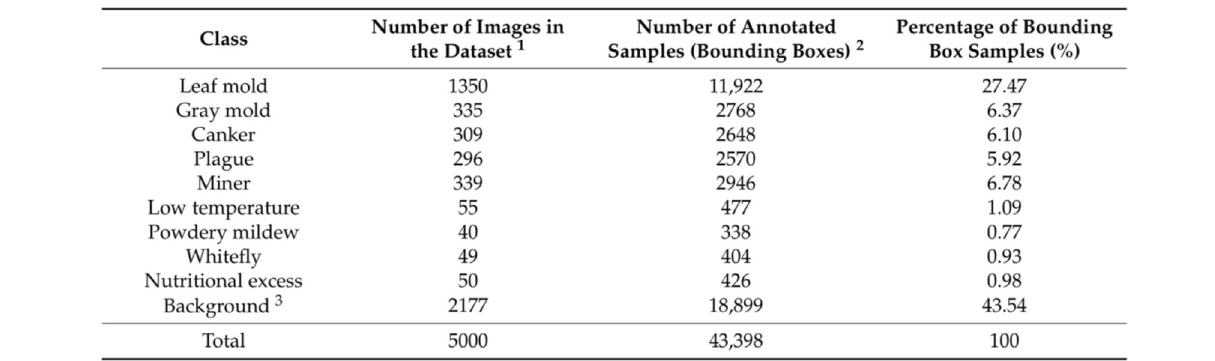
Table 1 The list of the classes included in our Cole pest and disease dataset and its annotated